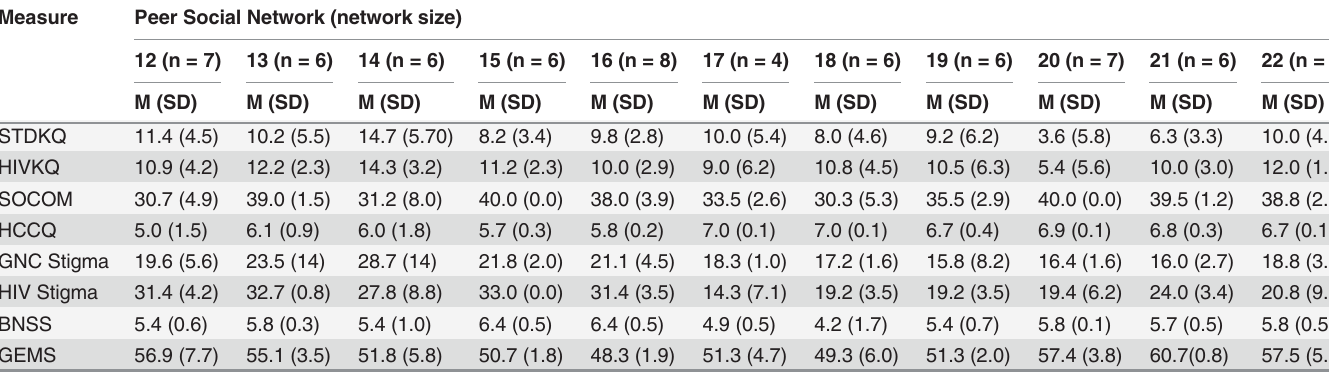
Table 6. Means and standard deviations on psychosocial variables for peer networks 12 – 22. Measure Peer Social Network (network